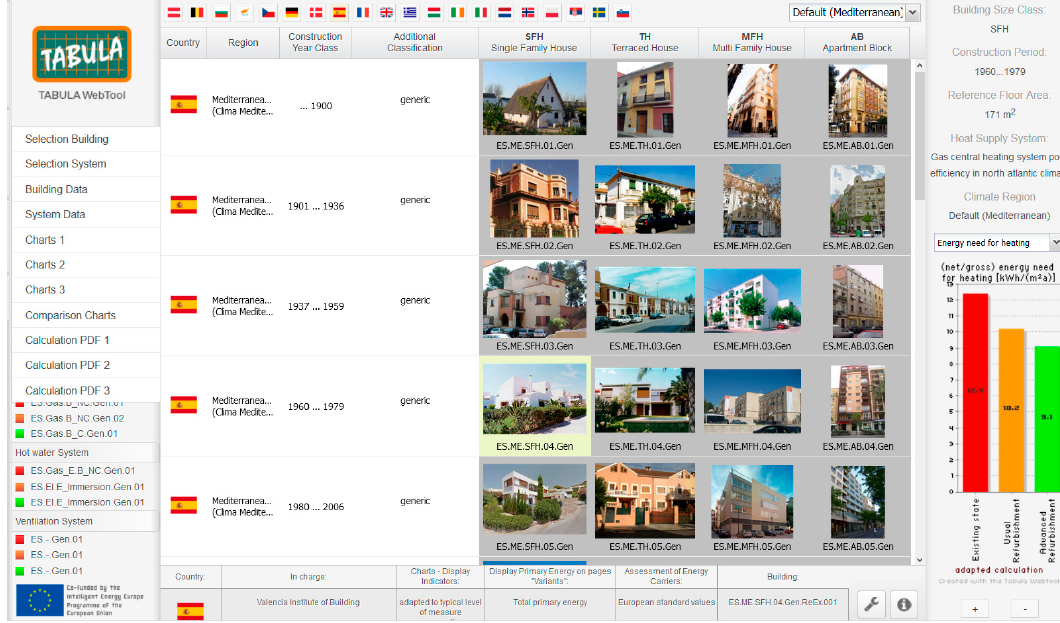
Figure 1. TABULA WebTool database interface [21].